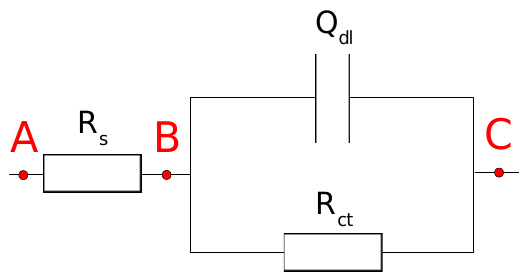
Figure 3. The equivalent electric circuit of the metal–solution interface.